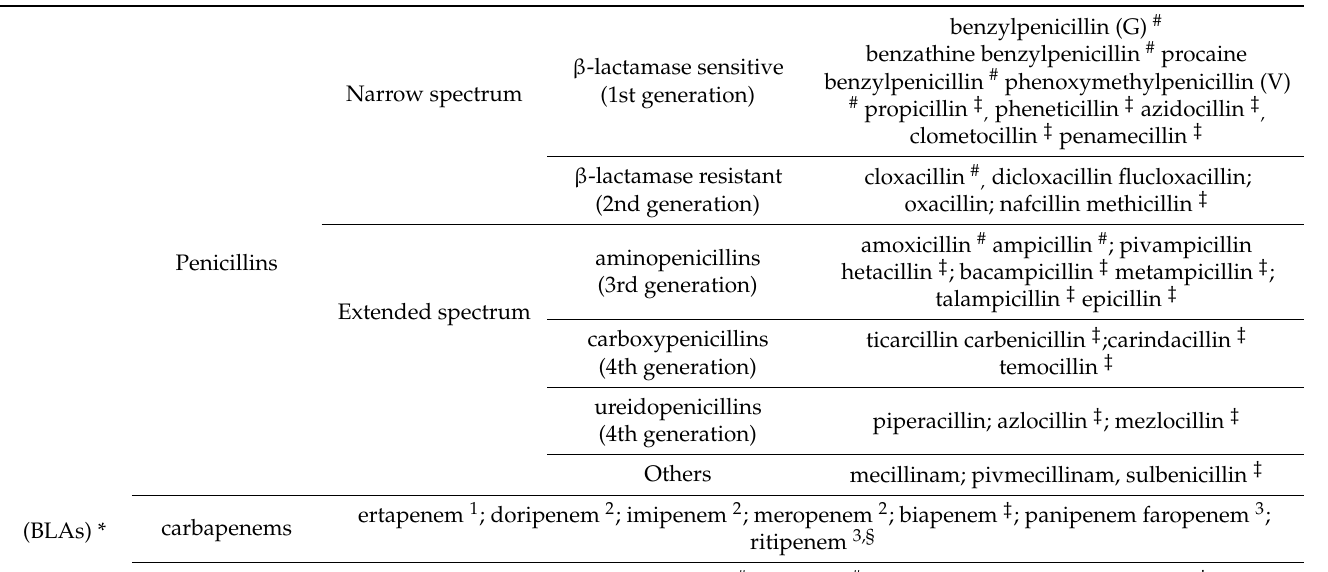
Table 1. The most relevant BLAs developed until